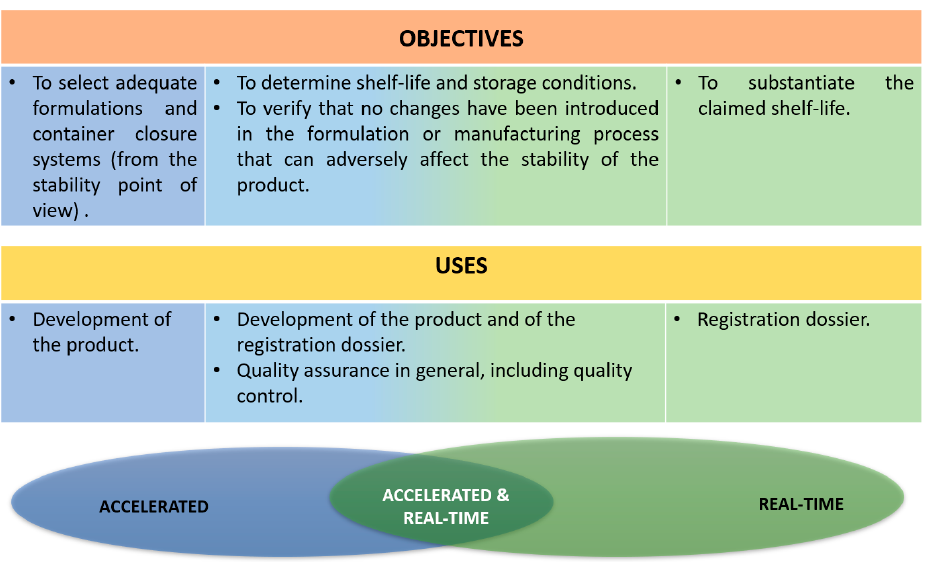
Table 3. Types of stability studies for FPPs. Modified from: [6,12]. Key: RT, Room temperature.